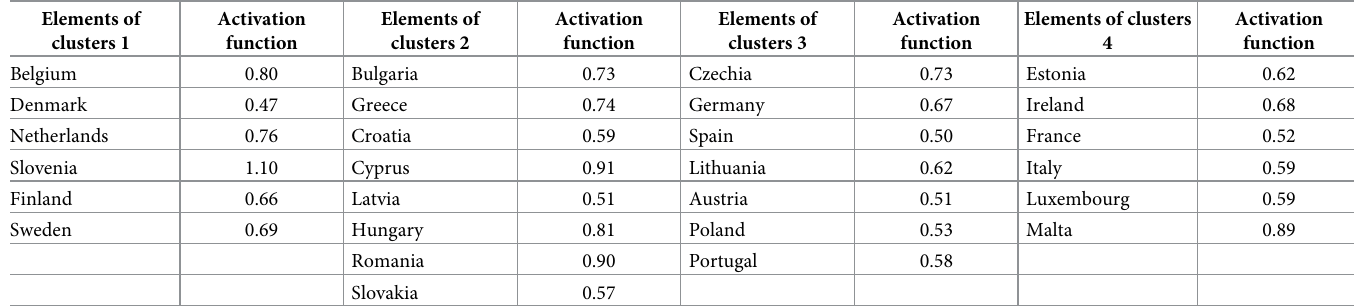
Table 7. The division of the EU countries into similar groups based on the examined indicators for all enterprises together with activation values.